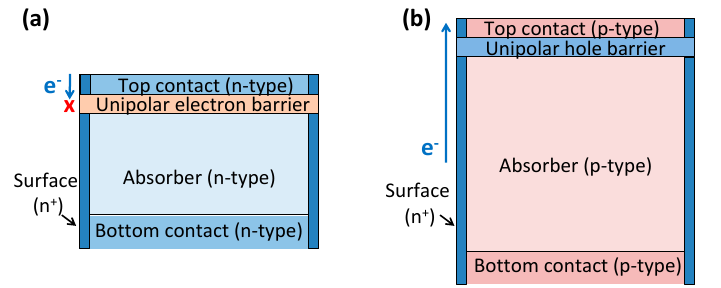
Figure 2 . Schematic layer structure diagrams of ( a ) an nBn detector, and ( b ) a pBp detector.